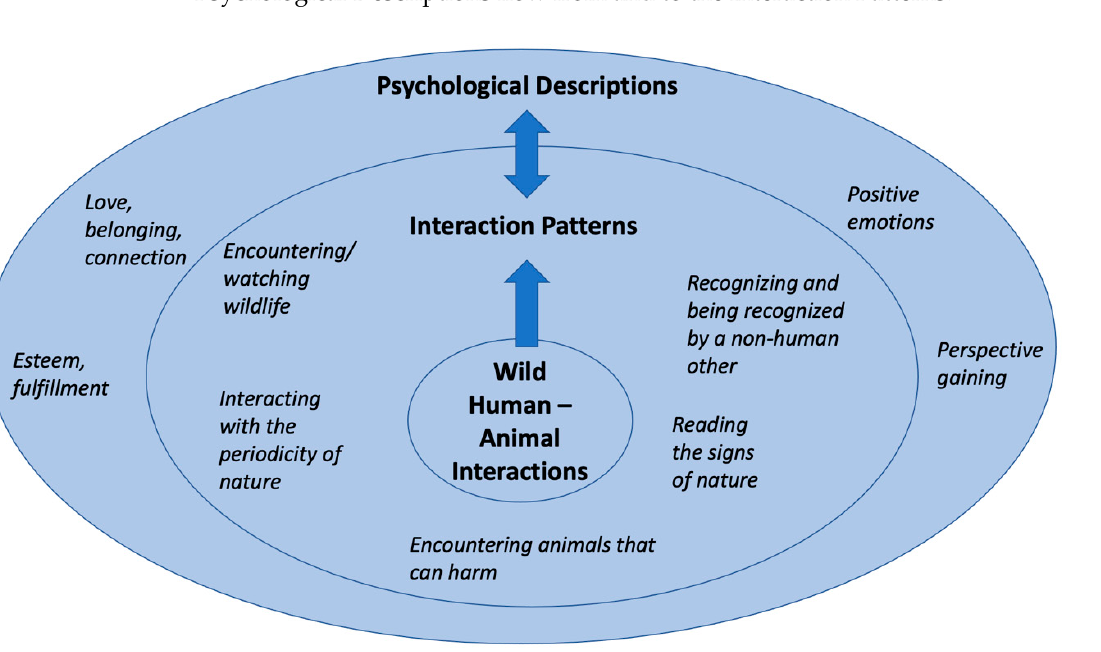
Figure 1. Visual representation of the embedded links between HAIs, Interaction Patterns and Psychological Descriptions.